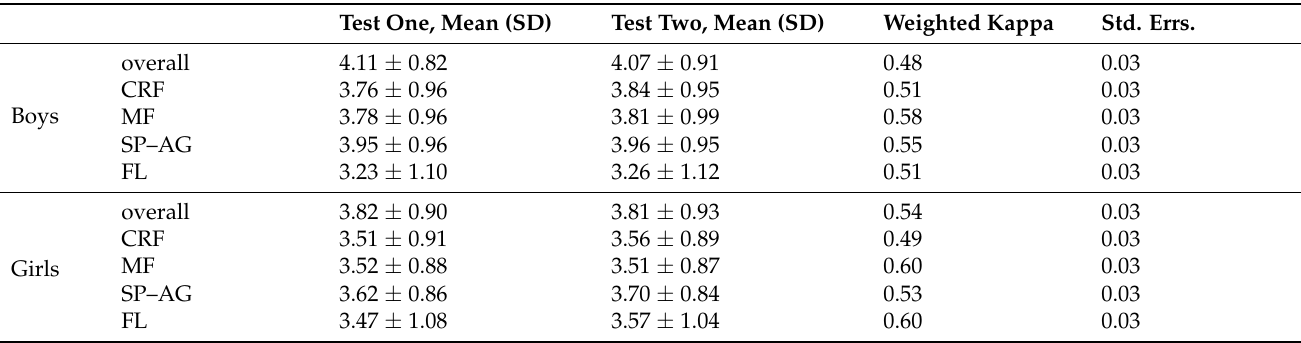
Table 2. Weighted kappa of International Fitness Scale by